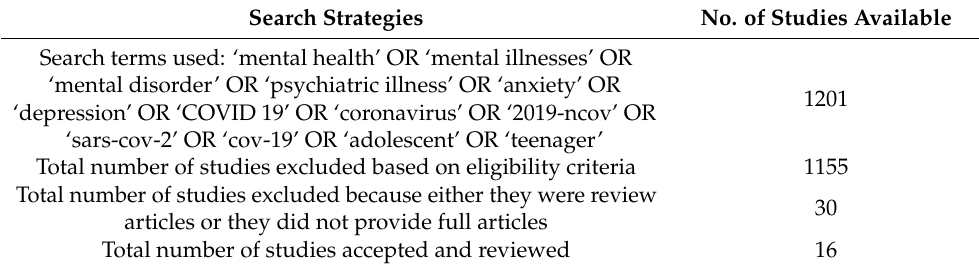
Table 2. Research Thread for all